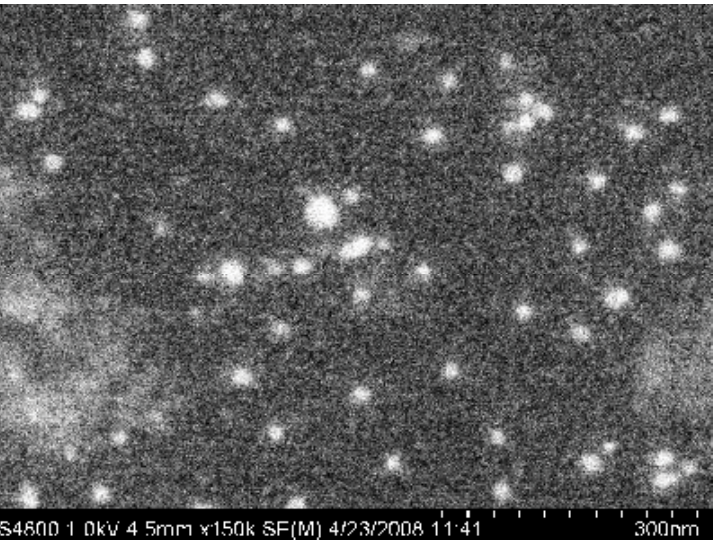
Fig. 1 An example of the micrograph of a sample of the prepared diamond-carbon powder, obtained with the scanning electron microscope.